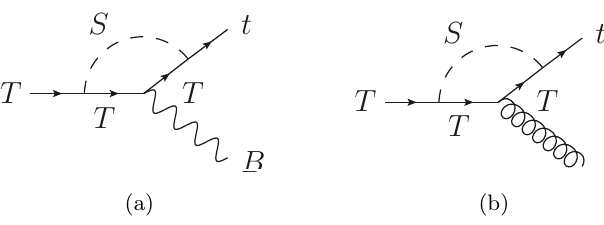
0 and EW symmetry is restored. !